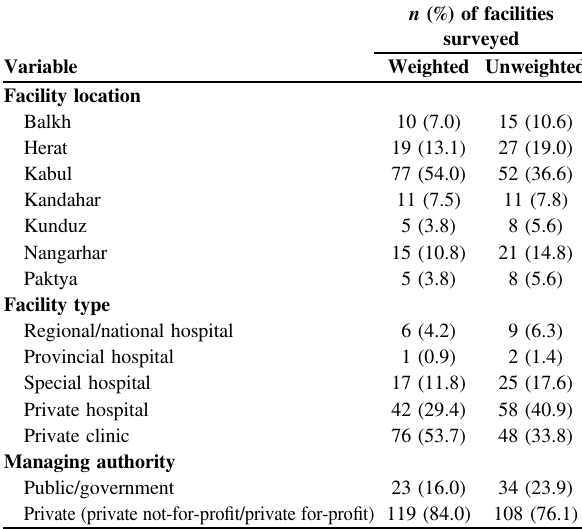
Table 1 Distribution of surveyed healthcare facilities by background characteristics, N =